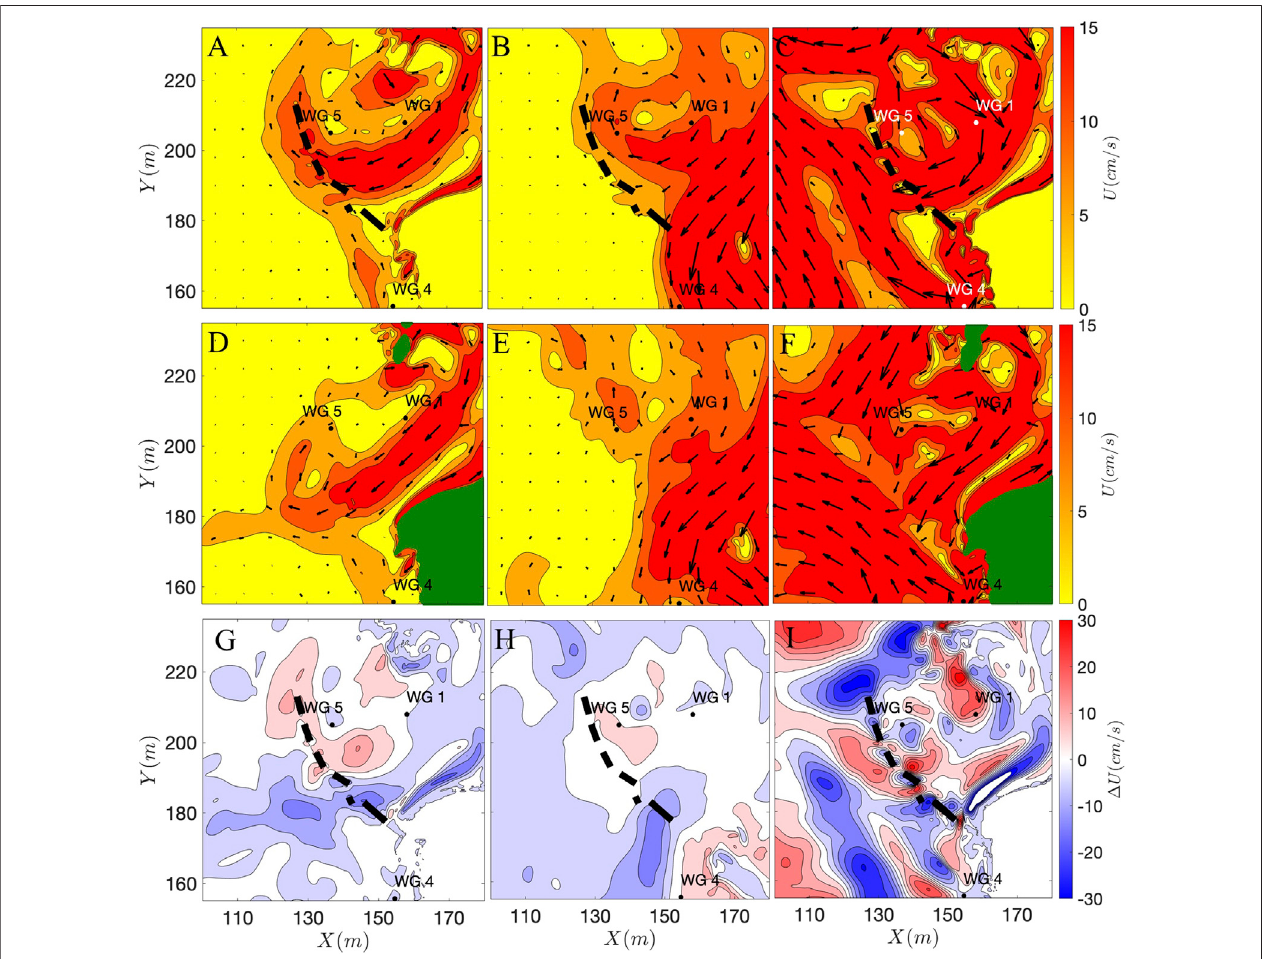
FIGURE 9 | Wave-driven current velocity for (A,D) Case 1, (B,E) Case 2, and (C,F) Case 3. In panels (A – C) CORs are present in the domain, while in panels (D – F) CORs are removed from the domain. Panels (G – I) illustrate the change of wave-driven current velocity due to CORs.